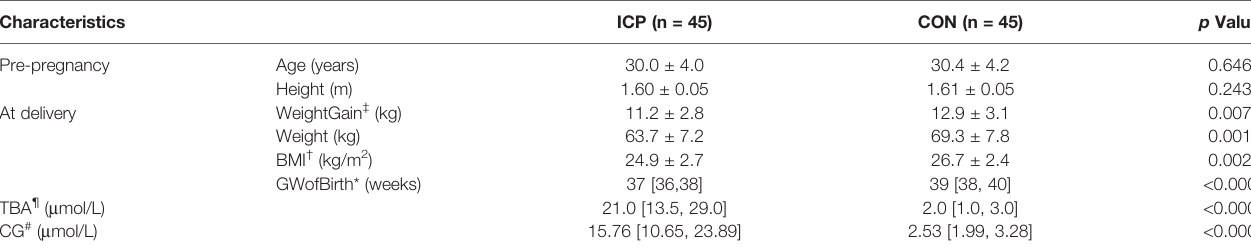
TABLE 1 | Characteristics of the